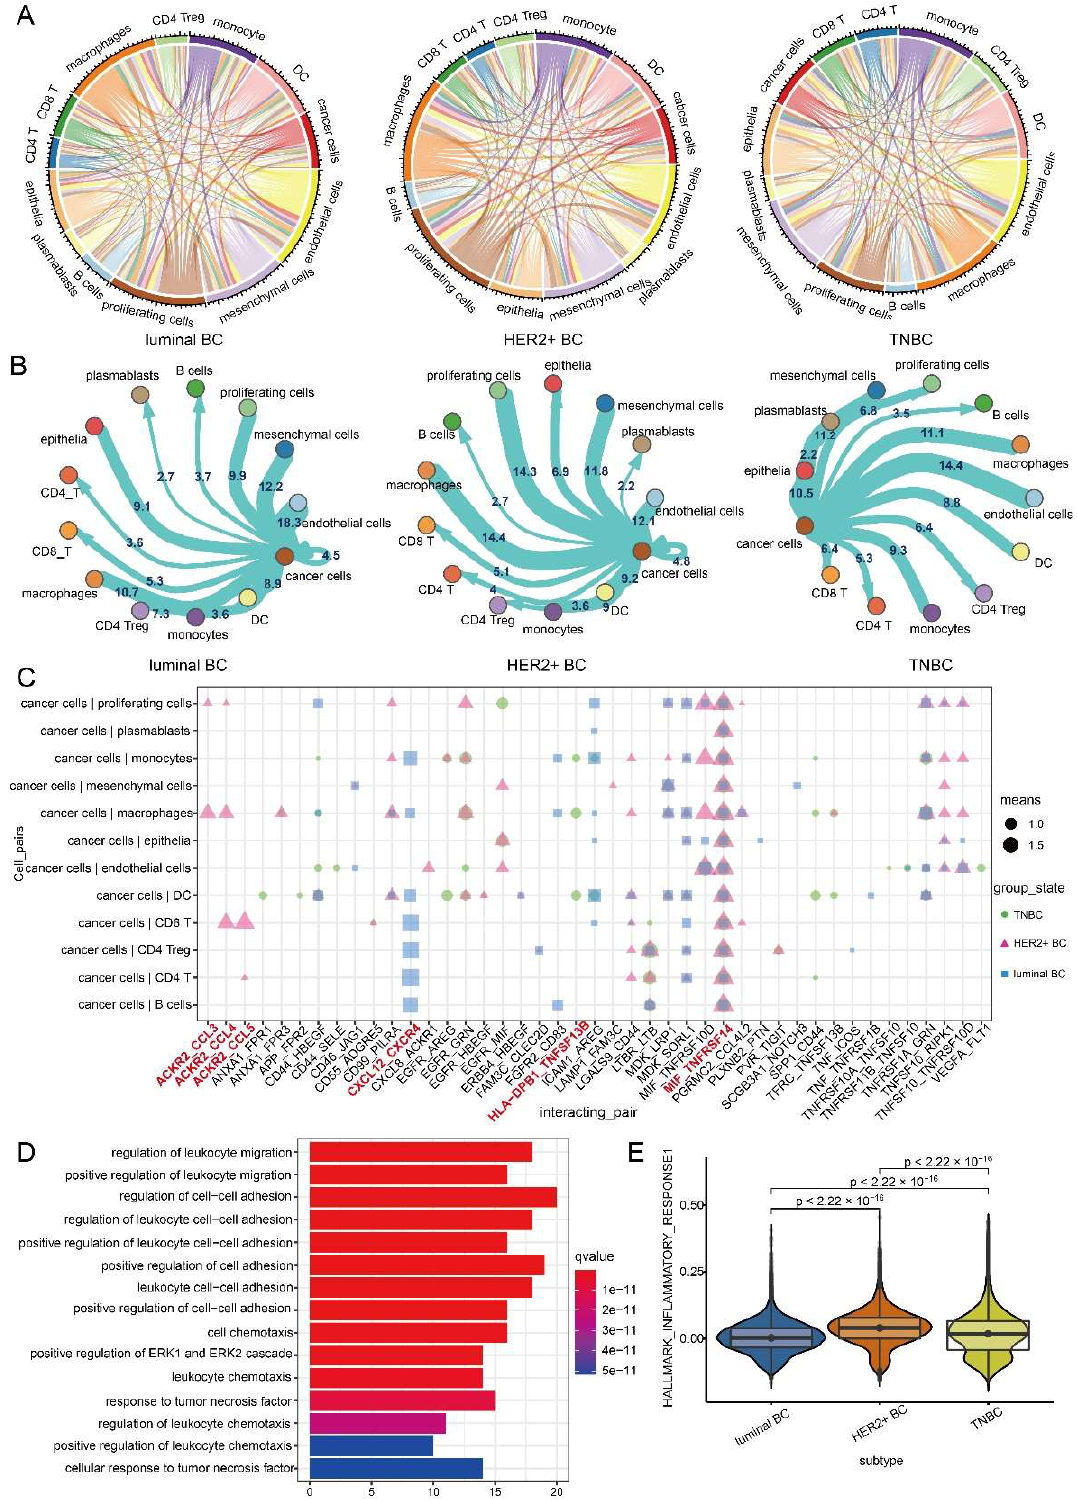
Figure 4. Cell communication of cancer cells leads to BC inflammatory microenvironment. ( A ) Over- all intercellular communication profiles of the three BC subtypes. ( B ) Intercellular communication frequency maps of cancer cells of three BC subtypes. ( C ) Receptor–ligand pairs for communication between cancer cells and other cells of the three BC subtypes. ( D ) GO biological process enrichment analysis of receptor–ligand genes for communication between BC cancer cells and other cells. ( E ) Scores of cellular inflammatory responses in the three BC subtypes.